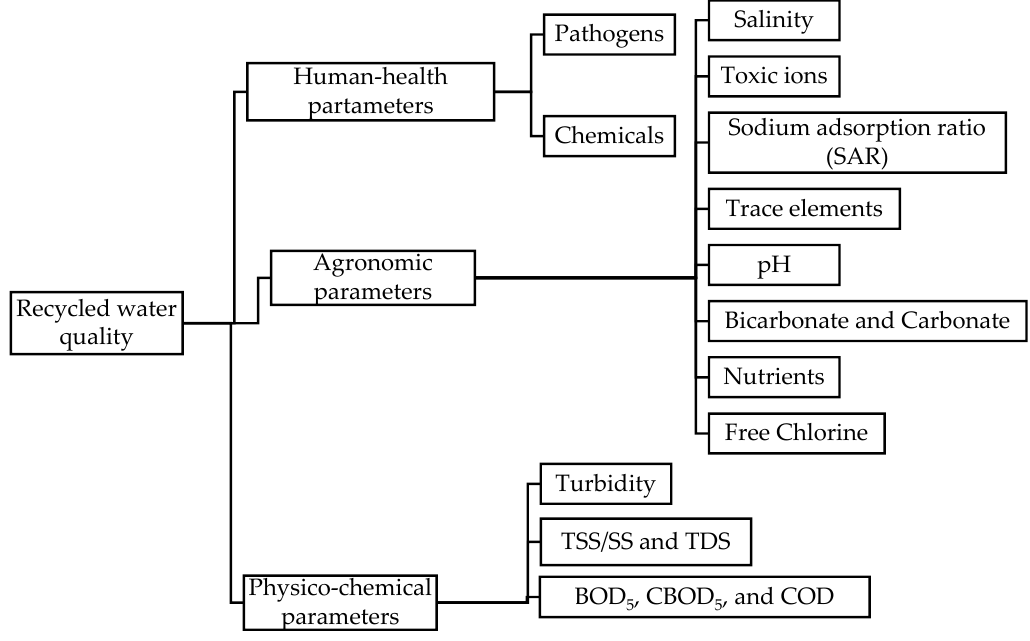
Figure 1. Agricultural water quality parameters.